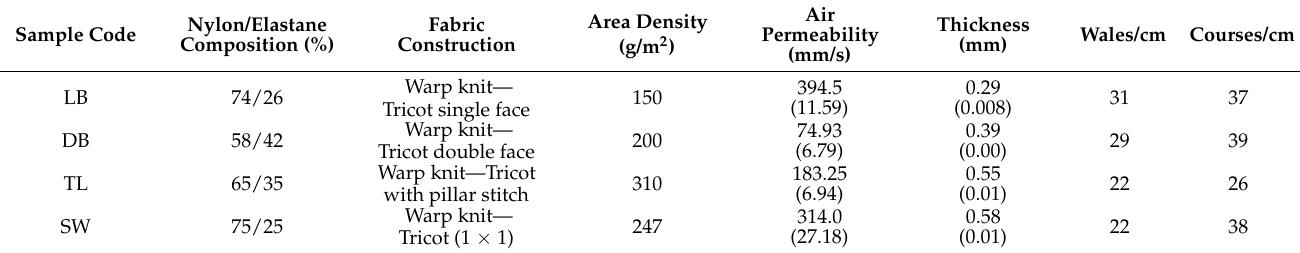
Table 1. Fabric information and